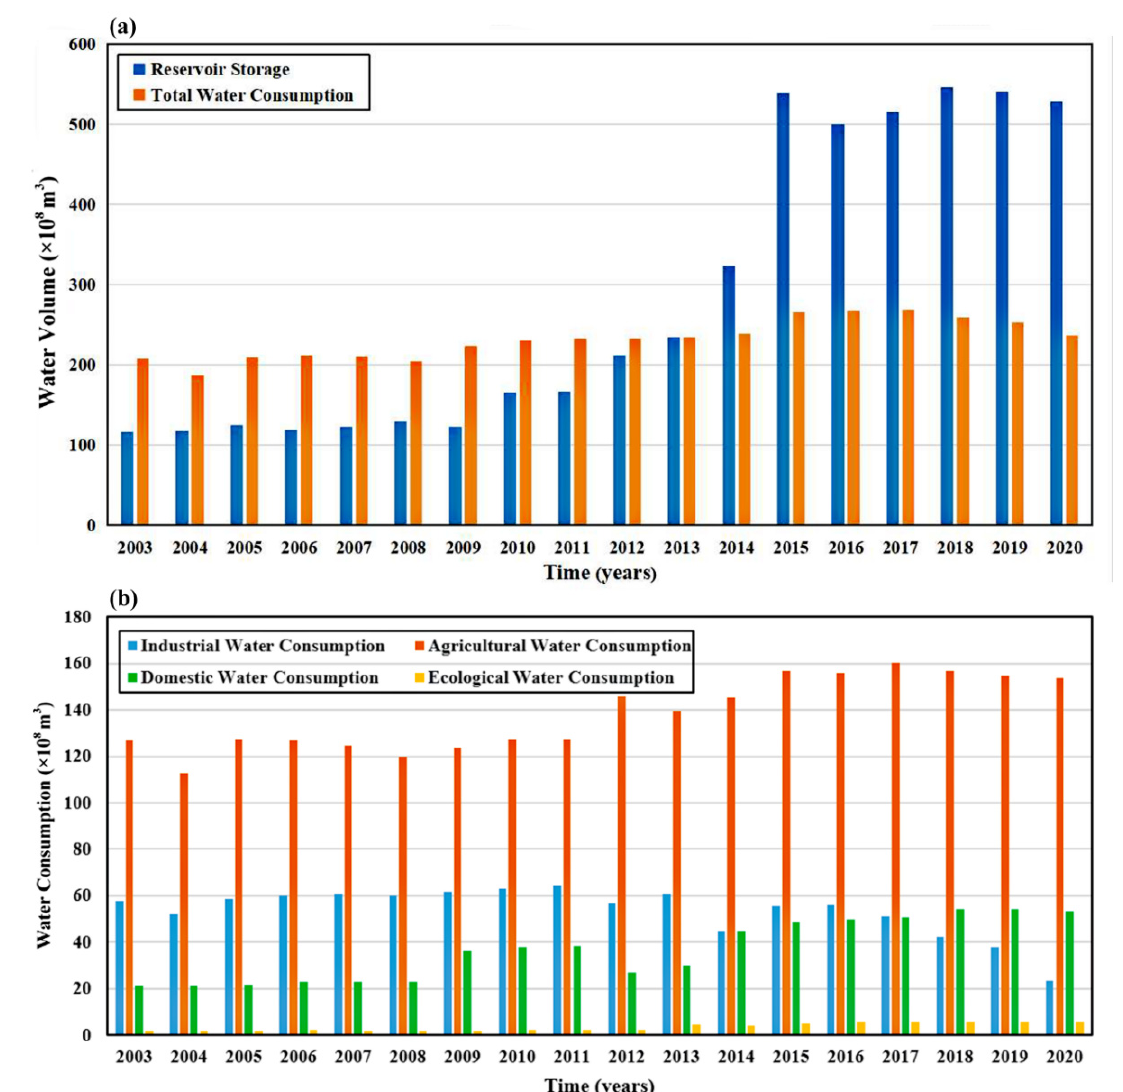
Figure 9. Statistics of water storage related to human activities in Sichuan from 2003 to 2020. ( a ) annual change of reservoir storage and total water consumption; ( b ) annual change of industrial, agricultural, domestic and ecological water consumption